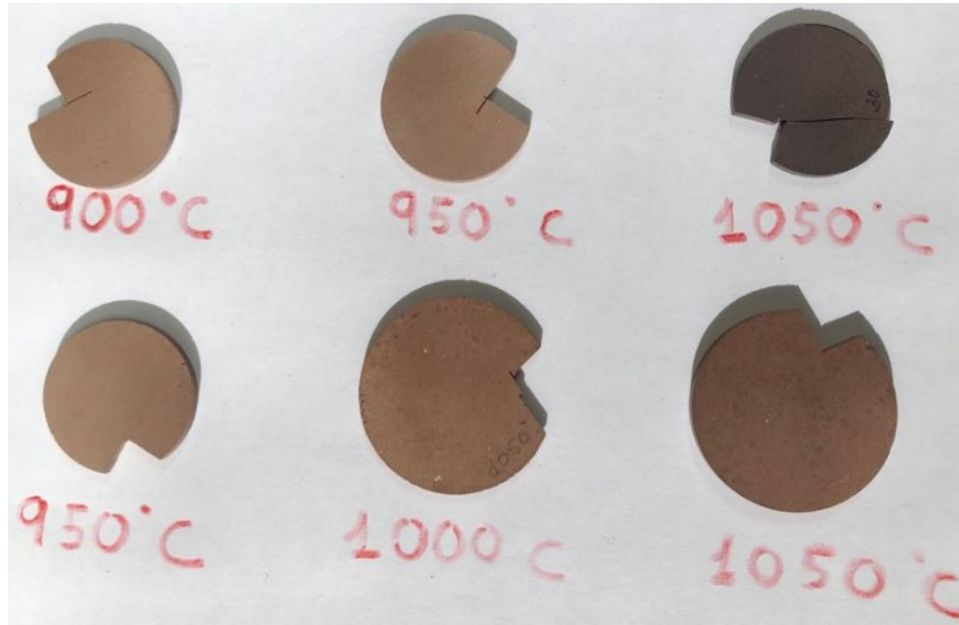
Figure 1. Test bodies fired at different temperatures.